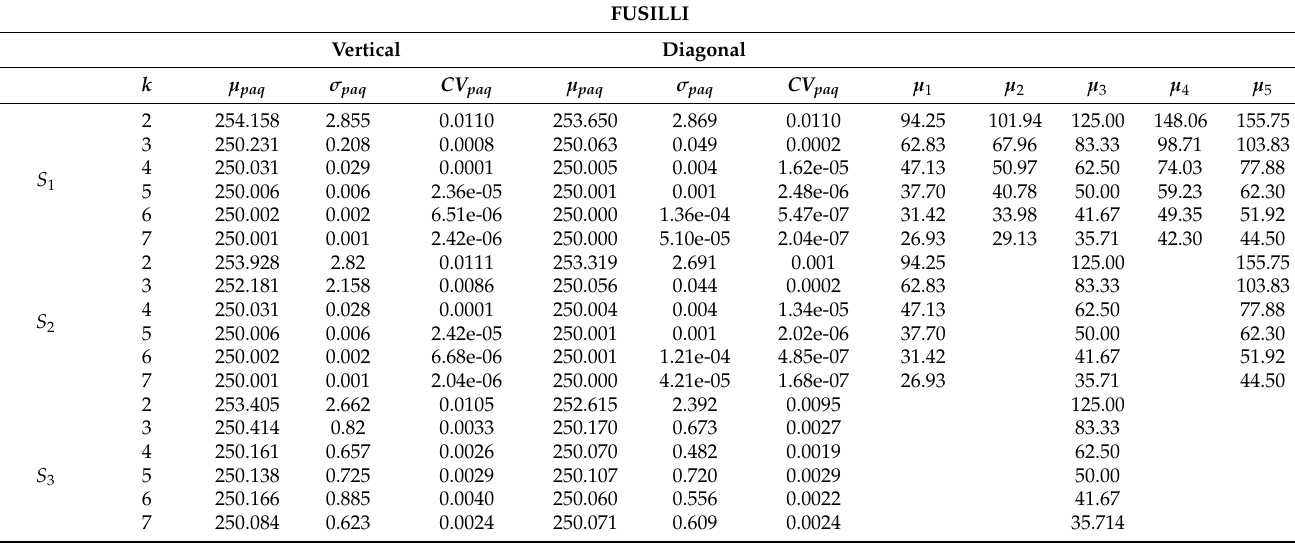
Table 5. Results of S 1 , S 2 , and S 3 strategies, for k = 2, 3, 4, 5, 6, and 7, and γ = 0.123.